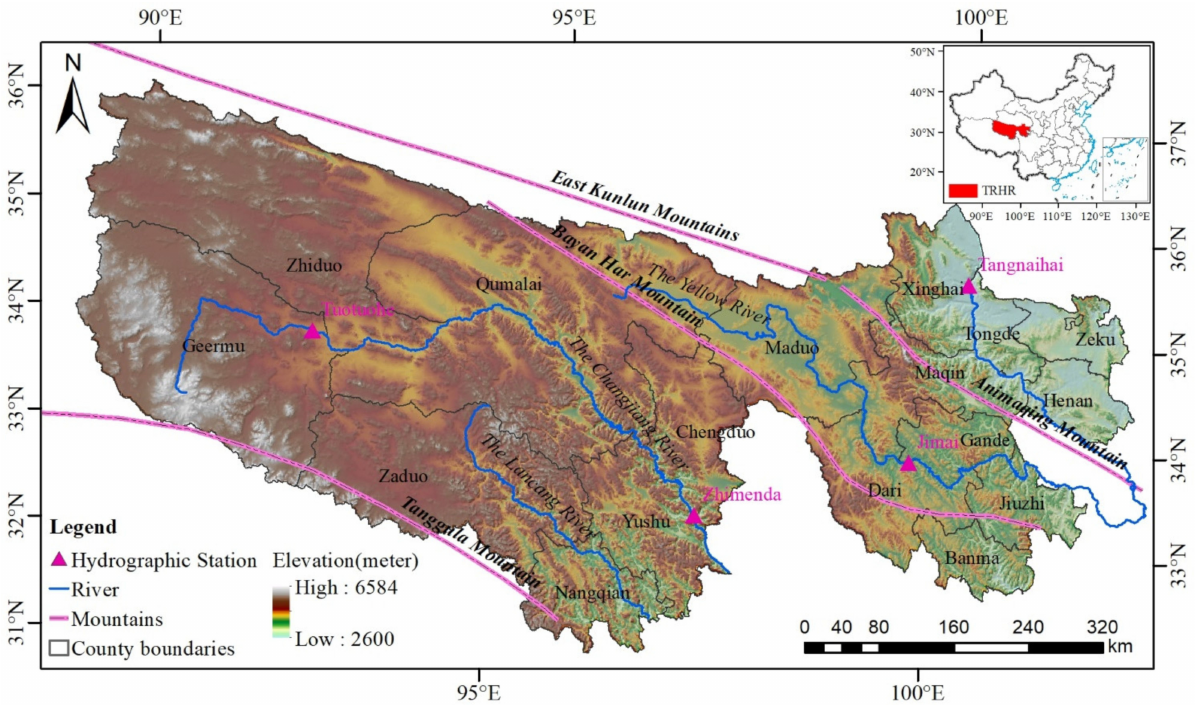
Figure 1. Digital elevation model of the